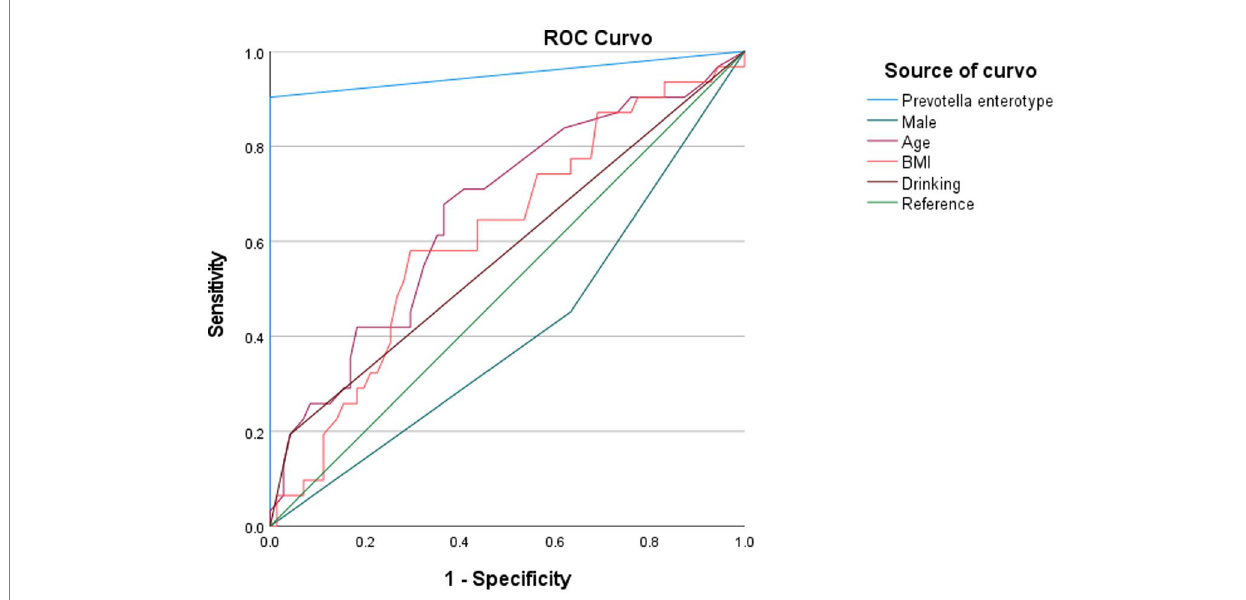
FIGURE 5 Diagnostic potential of Prevotella enterotype in predicting the incidence of colorectal adenoma. AUC, area under curve; BMI, body mass